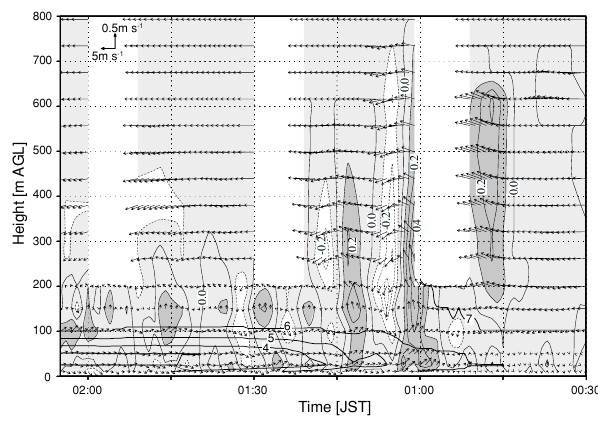
Fig. 11. Two-dimensional flow field derived from the wind pro- filer and the tower at 00:30 to 02:05 JST on 30 December 1997. Time runs right to left. Horizontal components are the front-normal horizontal wind. Vertical components are magnified by 10 times relative to the horizontal component. The gray scale with contours shows vertical components; upward (downward) airflow is repre- sented with dark shadow (white) regions, respectively. The gaps seen in between wind profiler observations are due to high mode and RASS periods. The temperature measured with the tower is also plotted to represent the gravity current. The profiler data has been shifted in time so that the arrival of the gravity current is coin- cident in the two data sets.